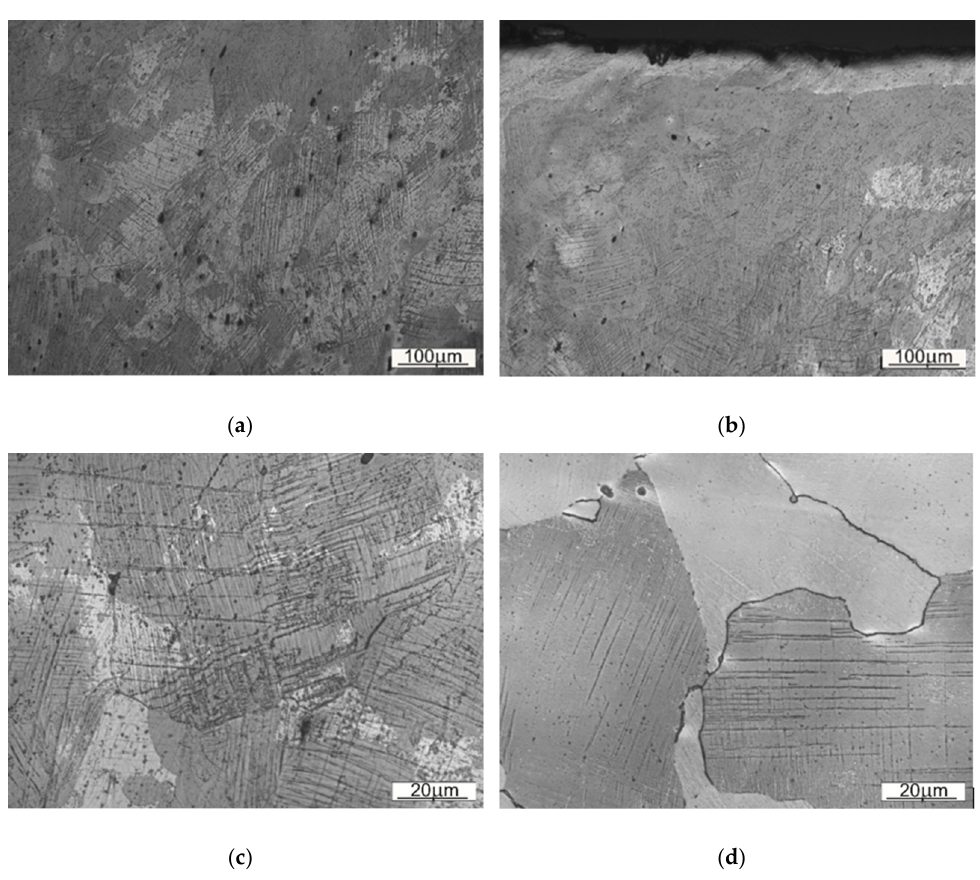
Figure 11. A view on the microstructure of the region located nearby the working surface of the sample SS2: ( a ) 20x magnification, ( b ) 20 x magnification, ( c ) 100x magnification ( d ), 100 x magnifi- sample SS2: ( a ) 20 × magnification, ( b ) 20 × magnification, ( c ) 100 × magnification ( d ), 100 × cation.